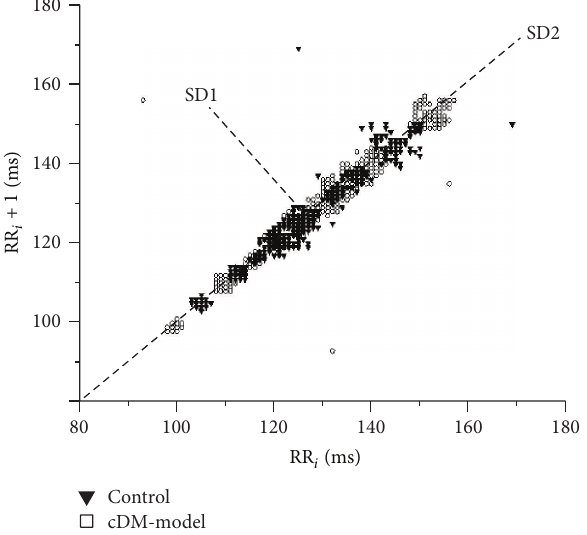
Figure 3: The Poincar´e plots. The plot was constructed with RR interval showing an increase in SD2 in diabetic animals. The open square shows values from cDM-model and control in dark